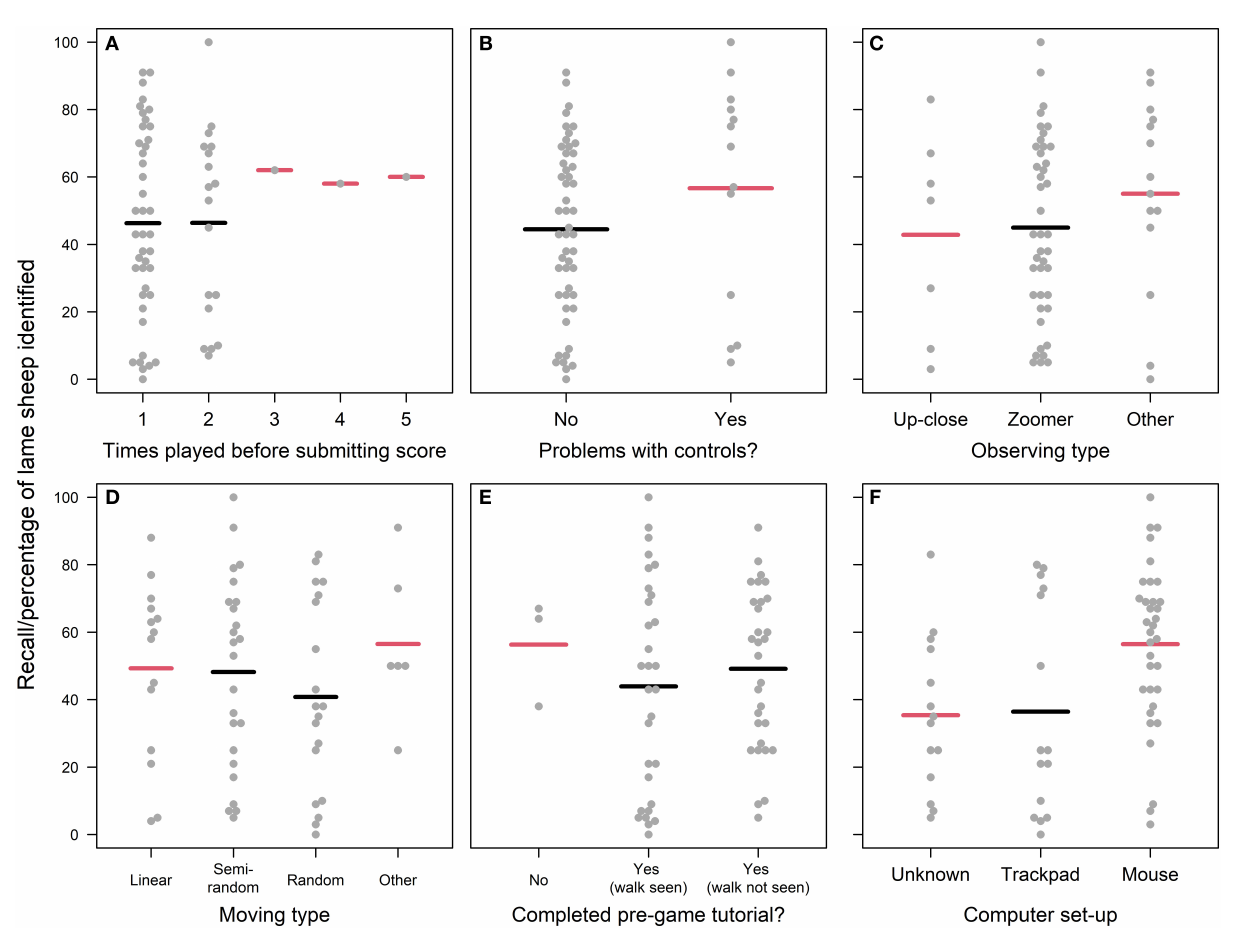
of assessing lameness, only lame sheep are usually marked.